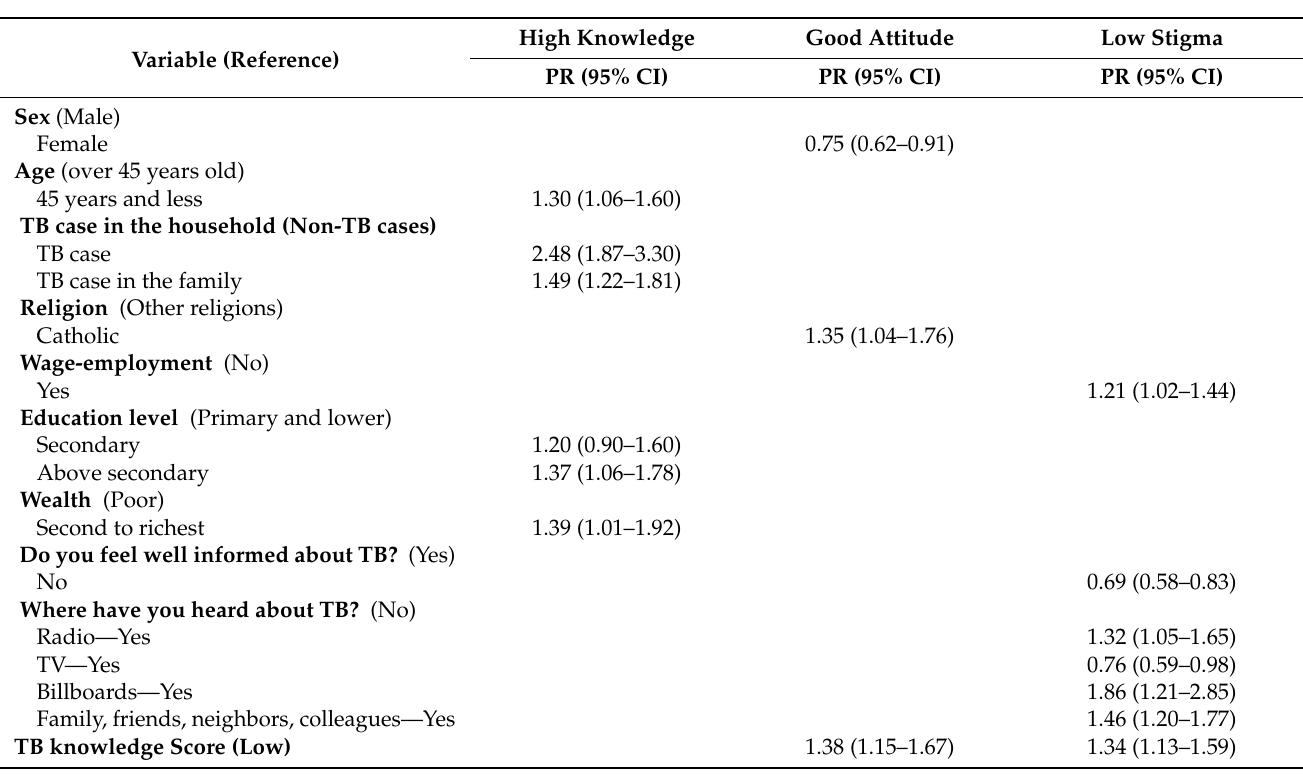
Table 2. Factors associated to high knowledge, good attitude, and low stigma related to tuberculosis in Equatorial